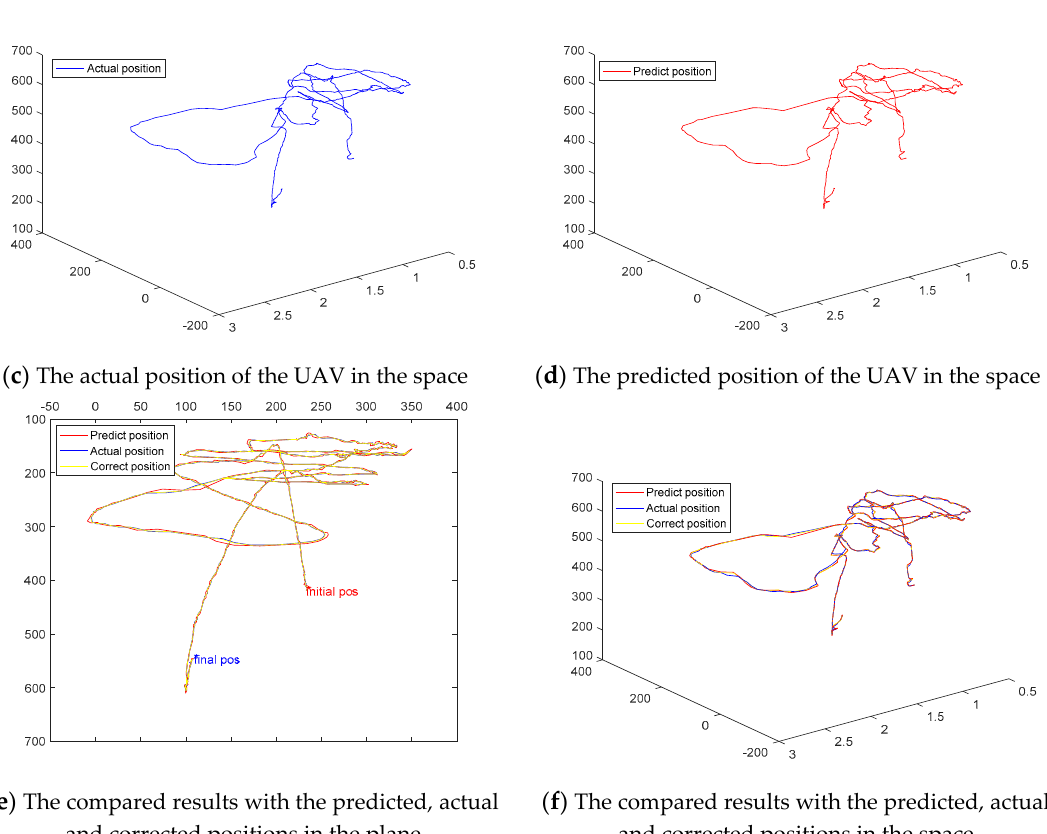
Figure 10. Illustration of the accuracy of the predicted position and scale of the UAV. Here, the Actual position (in blue) is the actual UAV position which is calibrated by manual in the video, the Predict position (in red) is predicted by the instantaneous motion estimation method and the Correct position (in green) is filtered position by Kalman filters. ( a , b ) indicate respectively in-plane predicted and actual positions. ( c , d ) show apart 3D predicted and actual positions where the scale represents the dept motion. ( e , f ) display the overall results.